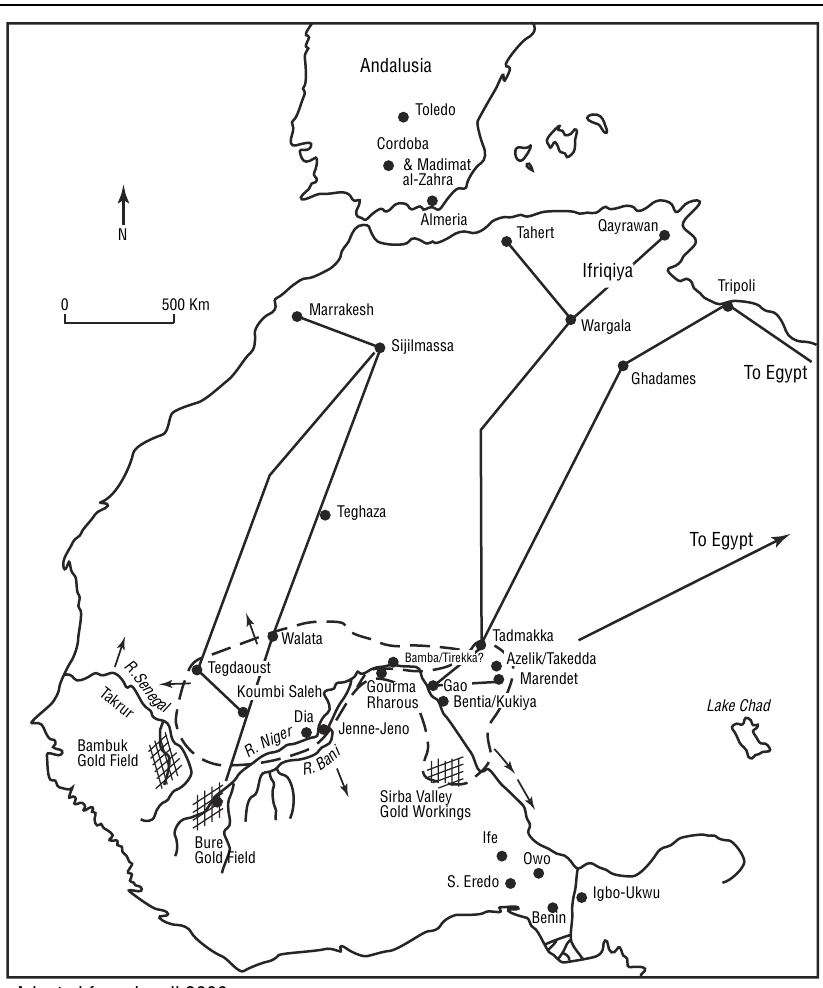
Figure 2 – Ghana/Wagadu and Kawkaw/Gao tributary systems and interacting networks and Lower Niger basin